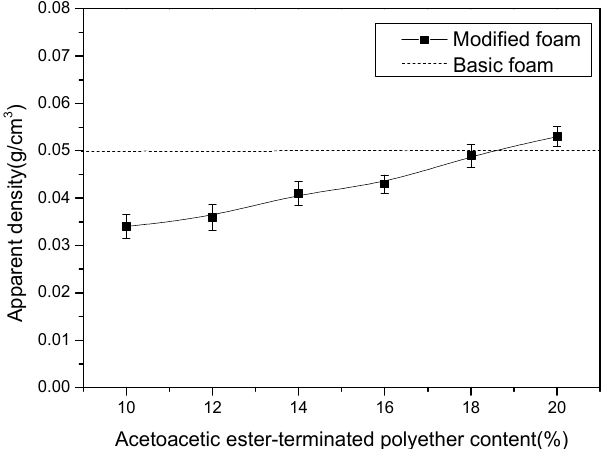
Figure 9. The effect of the acetoacetic ester-terminated polyether with different contents on the apparent density of the foam.